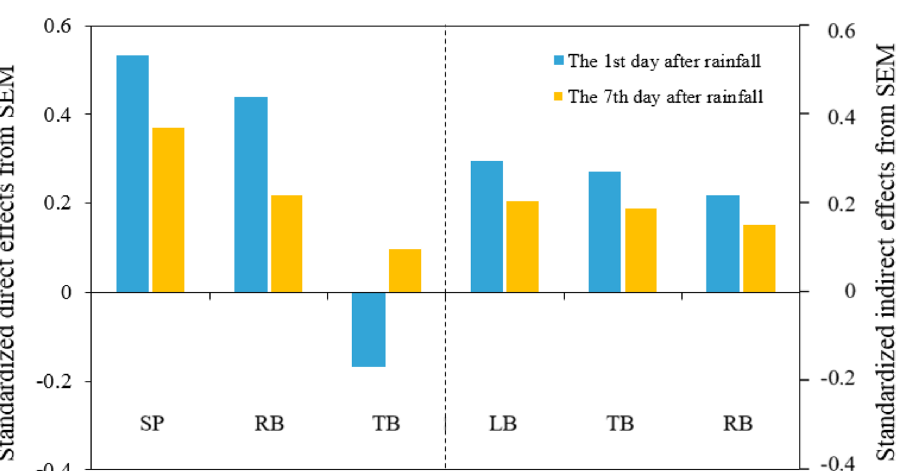
Figure 7. Standardized direct and indirect effects on the contribution of heavy rainfall to soil water from structural equation modelling (SEM). SP soil properties, RB root biomass, TB tree biomass, LB litter